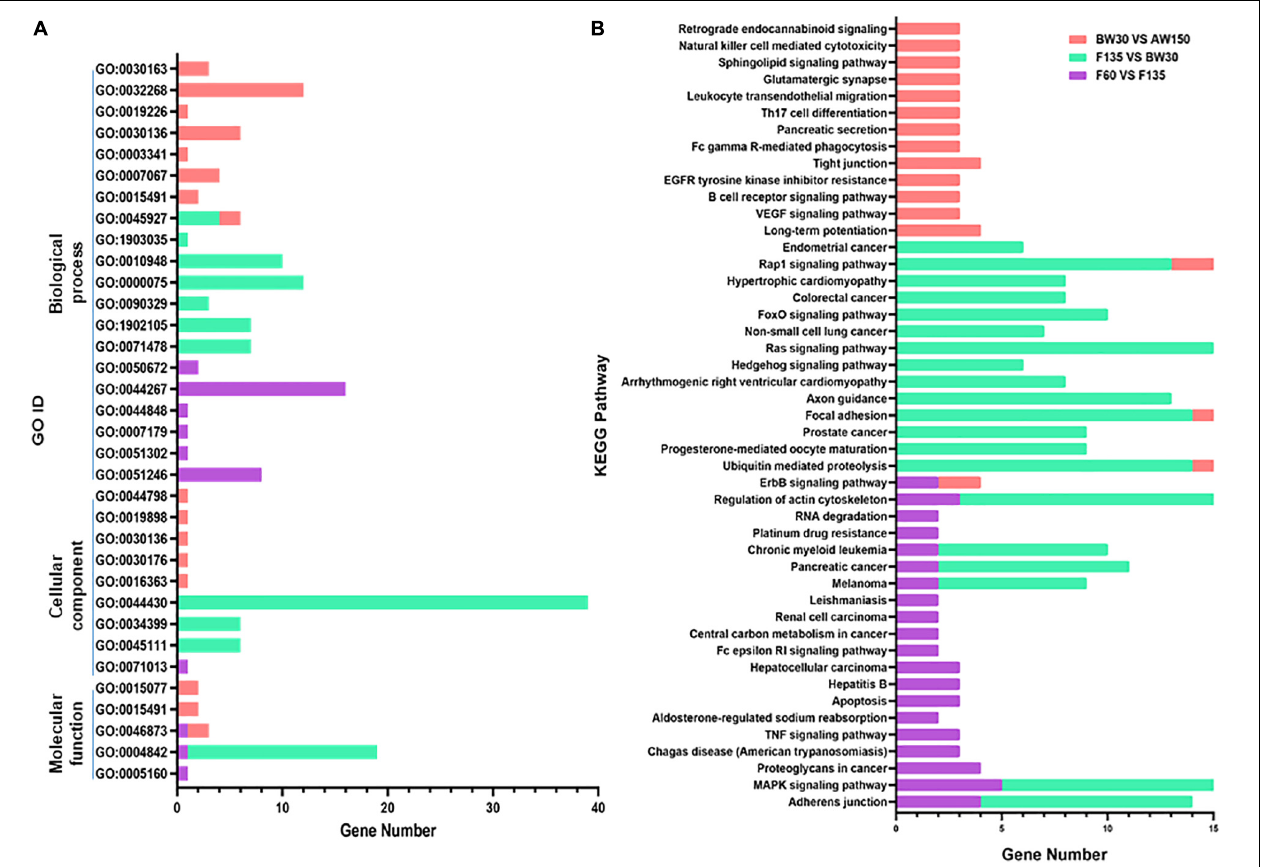
FIGURE 4 | (A) The significantly enriched GO terms ( p < 0.01) in the biological process, molecular function, and cellular component categories. (B) Top 20 KEGG enrichment